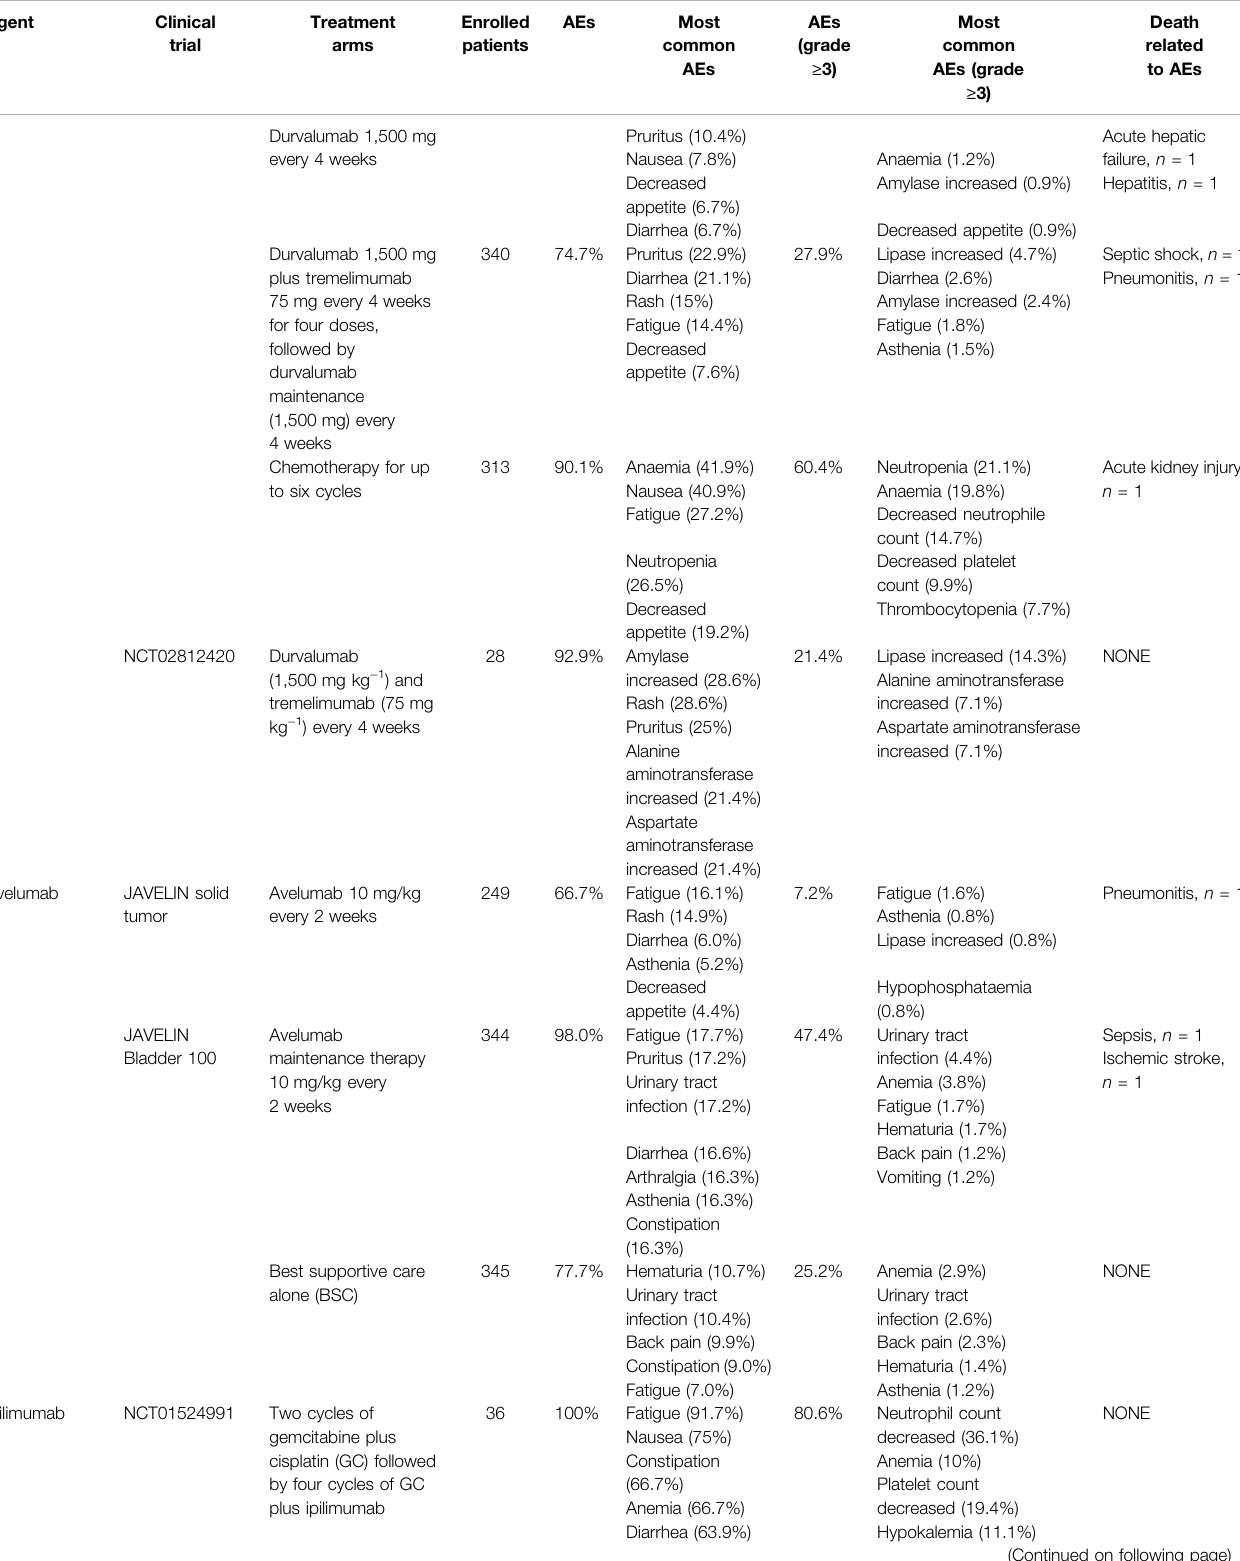
TABLE 3 | ( Continued ) Key clinical trials ’ safety data of ICIs in patients with